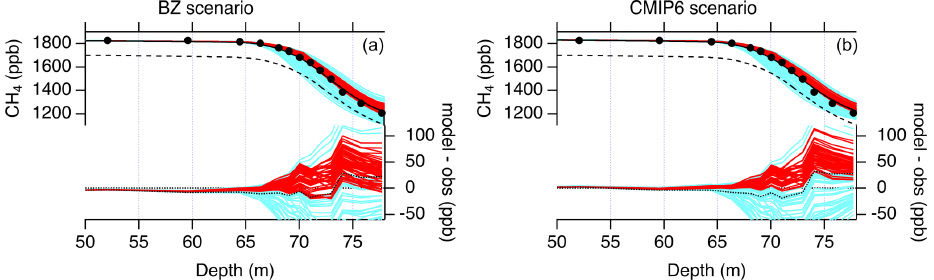
Figure 8. Same as Fig. 6 but for CH 4 in the NGRIP firn. Simulation results with the atmospheric scenarios of BZ and CMIP6 are shown in panels (a) and (b) , respectively. The black dashed lines indicate the profiles calculated with the atmospheric scenarios for Antarctica (red line in Fig. 2).